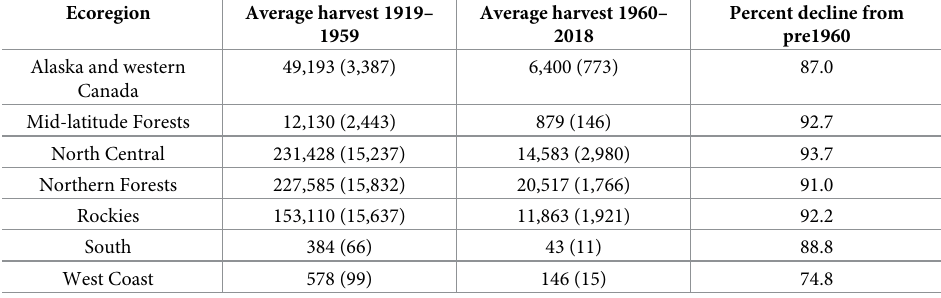
Table 2. Average number (and standard error) of weasels harvested annually in the United States and Canada from 1919 to 1960 and from 1961 to 2019.